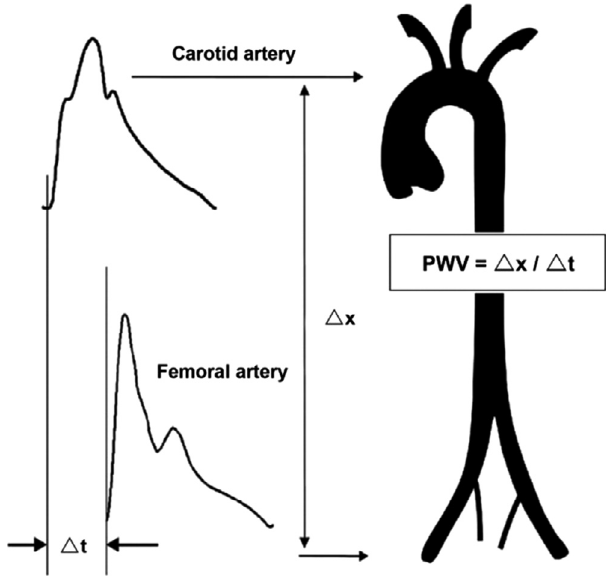
Table 1 Methods to assess arterial stiffness. Carotid-Femoral Pulse Wave Velocity (cfPWV)